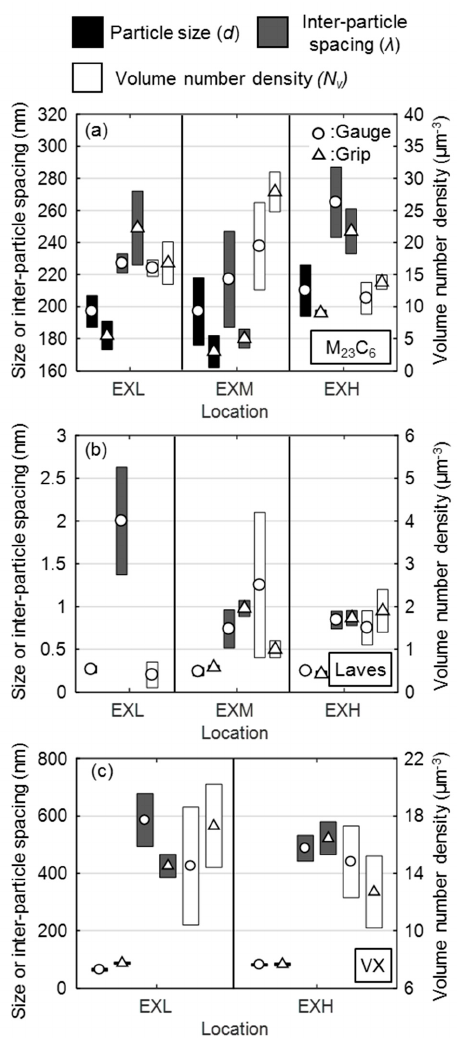
Figure 15. Error bar plots of particle diameter, inter-particle spacing and volume number density of ( a ) M 23 C 6 (EXL-2570, EXM-2467, EXH-2560 particles), ( b ) Laves phase (EXL-40, EXM-226, EXH-364 particles), and ( c ) VX precipitates (EXL-348, EXH-345 particles) in the gauge (circles) and grip (triangle) regions of the EXL and EXH material.